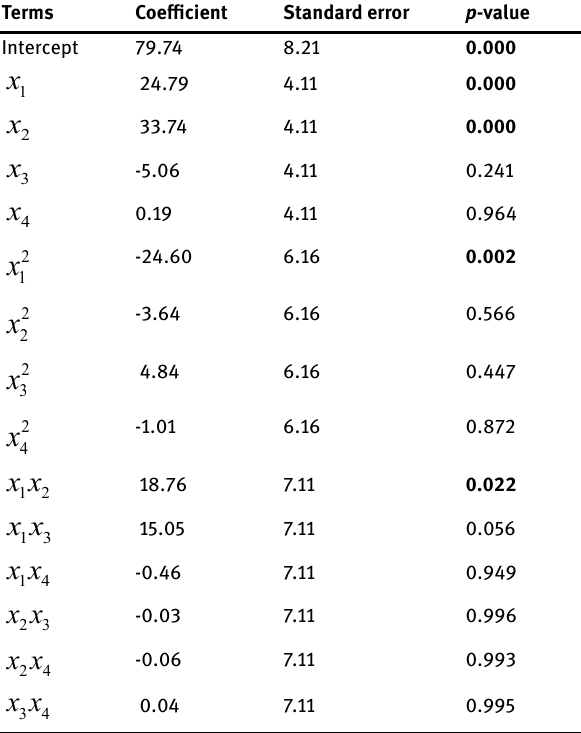
Table 4: Regression analysis of a second-order model for optimization of the heavy metal adsorption capacity of micronized